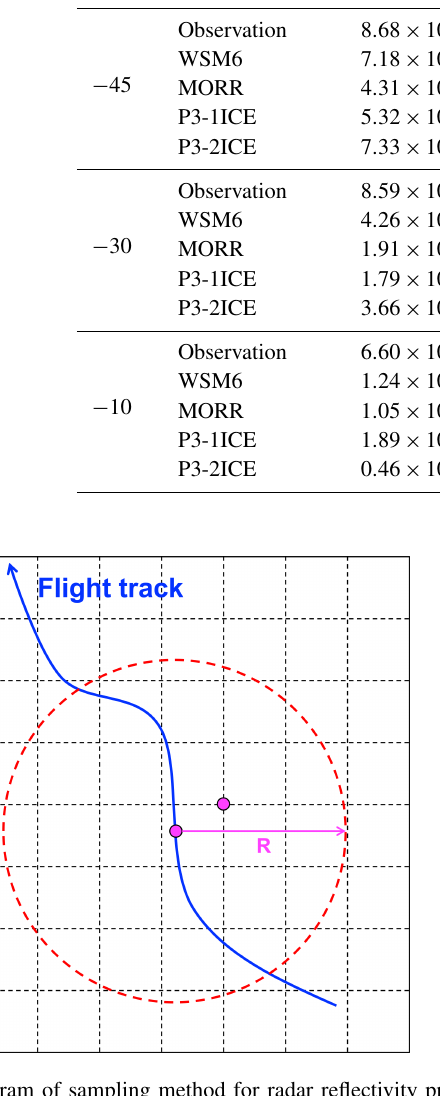
Figure 6. Diagram of sampling method for radar reflectivity pro- files. R = 100km here. The two magenta points at the flight track and model grid point represent the horizontal locations of observed and simulated radar reflectivity profiles. See text for